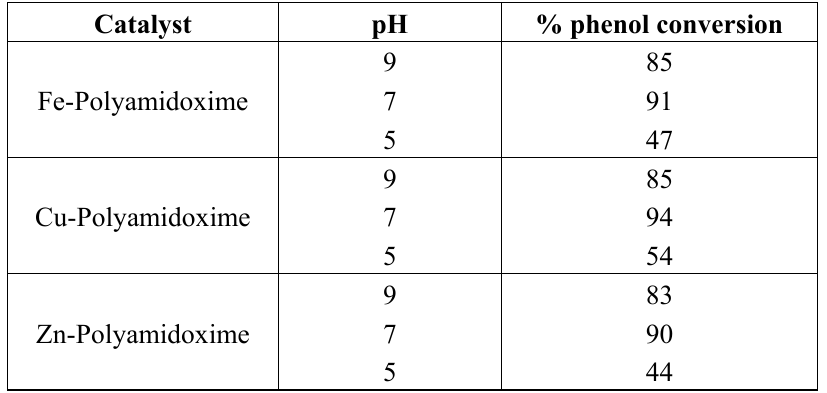
Table 3. Effect of